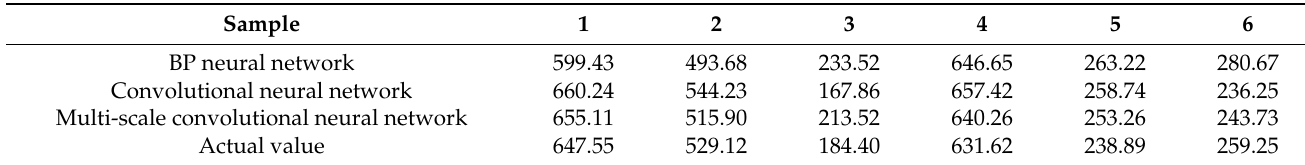
Table 4. Comparison table of partial predicted values and actual